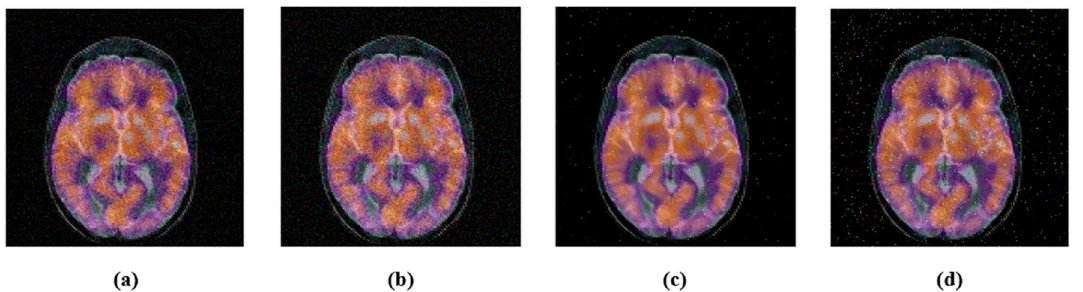
Figure 5. Image after JPEG compression attack: ( a ) JPEG 30, PSNR = 32.1397; ( b ) JPEG 50; PSNR = 34.1217; ( c ) JPEG 70; PSNR = 36.4392; ( d ) JPEG 90; PSNR = 46.7826.